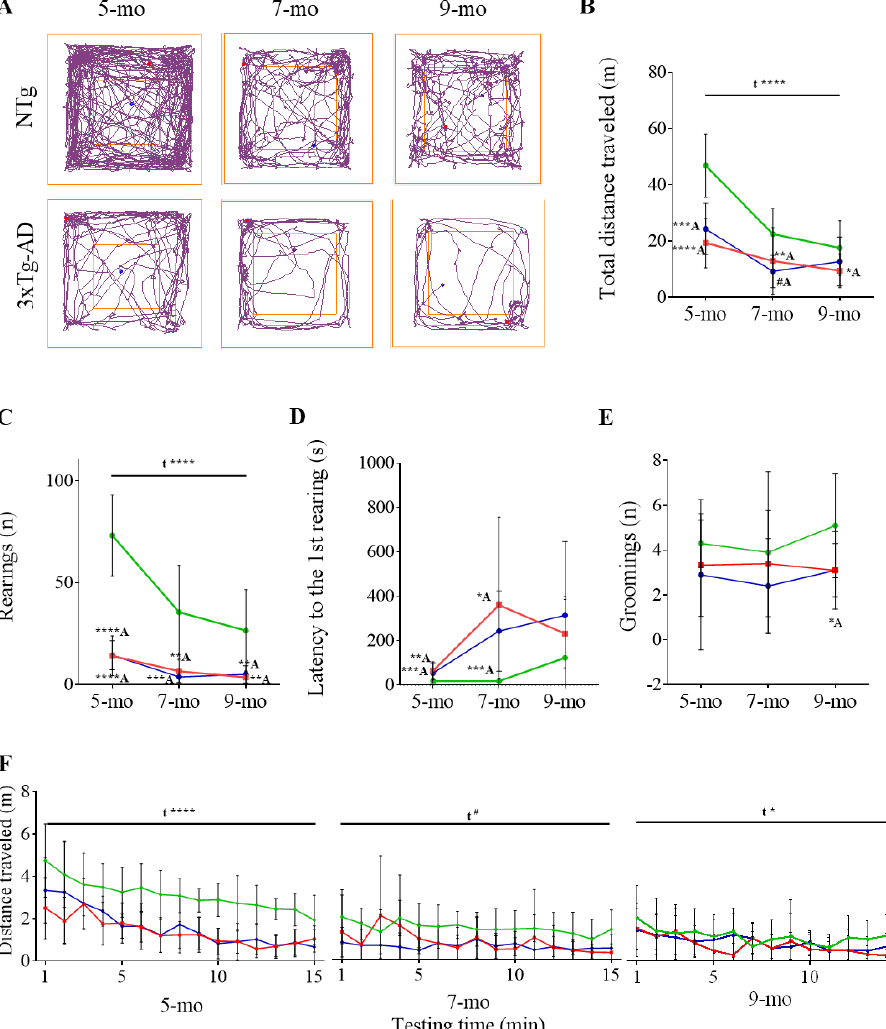
Figure 3. BPSD-like symptoms as tested in the open-field test. ( A ) Track plots of the pathway followed by PBS-treated NTg and 3xTg-AD representative animals. The blue point indicates the animal location at the starting point and the red point the final location. ( B – E ) Evolution of NTg (green), 3xTg-AD (red), and scFv-h3D6-treated 3xTg-AD (blue) mice with age considering B) the distance travelled (m), ( C ) number of rearings, ( D ) latency to the first rearing (s), and ( E ) number of rearings. ( F ) Distance travelled over-time at di ff erent ages. Values are represented by means and error bands correspond to SD. # indicates a low, but not significant, p -value (0.05 < p ≤ 0.1) (Total distance travelled (m), 7-mo, NTg vs. 3xTg-AD-PBS, t = 2.022, p = 0.0583). * significant di ff erences p ≤ 0.05, ** p ≤ 0.01, *** p ≤ 0.001, **** p ≤ 0.0001. A refers to NTg mice.